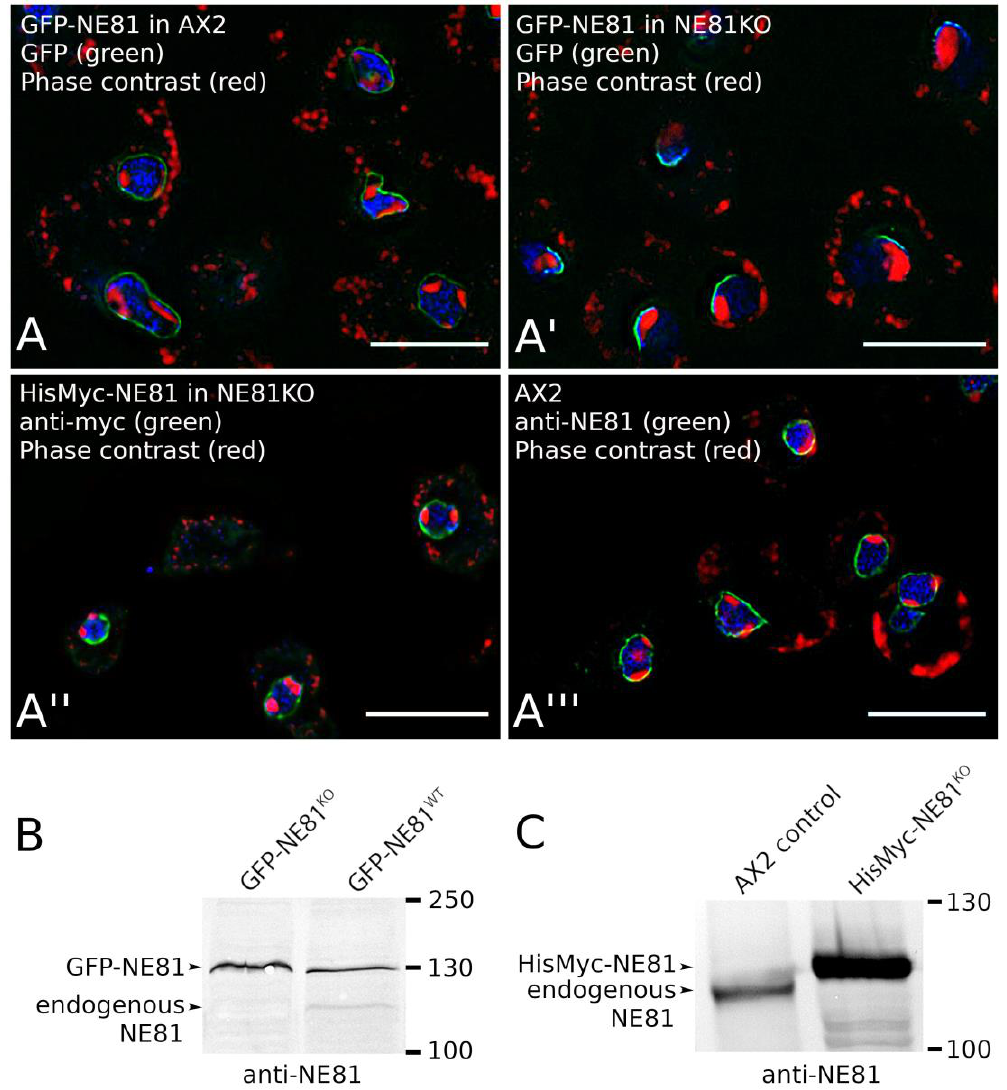
Figure 3. Expression of tagged NE81 in AX2 control cells or NE81 knockout cells. ( A ) Fluorescence deconvolution microscopy using a PlanApo 1.4/100× objective; GFP-NE81 cells ( A ), GFP-NE81 KO cells ( A′ ), HisMyc-NE81 KO cells ( A′′ ), and AX2 control cells ( A′′′ ) were fixed with glutaraldehyde, stained with 4′,6-diamidino-2-phenylindole (DAPI) and, if appropriate ( A′′′ ), with anti-Myc/anti-mouse-AlexaFluor 488 or anti-NE81/anti-rabbit-AlexaFluor 488. Scale bar = 5 µm. NE81 fluorescence is shown in green, DAPI in blue, and inverted phase contrast emphasizing the dark nucleoli is shown in red. ( B , C ) Immunoblots stained with alkaline phosphatase/NBT/BCIP show the absence of endogenous NE81 in the respective knockout (KO) strains and the band shift of the tagged protein compared to endogenous NE81.